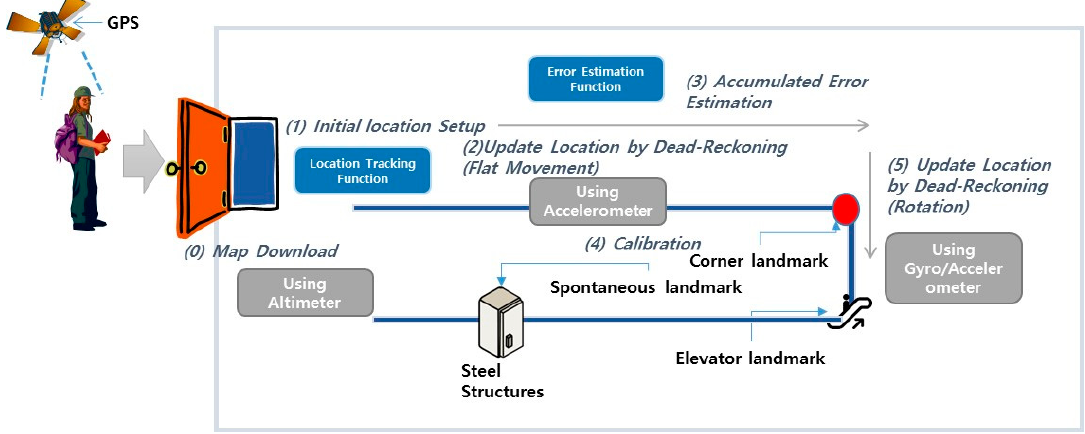
Figure 5. User location estimation by continuous calibration.